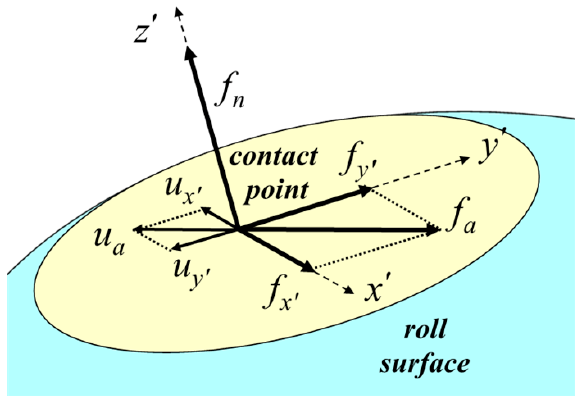
Figure 3. Schematic of the contact modeling.